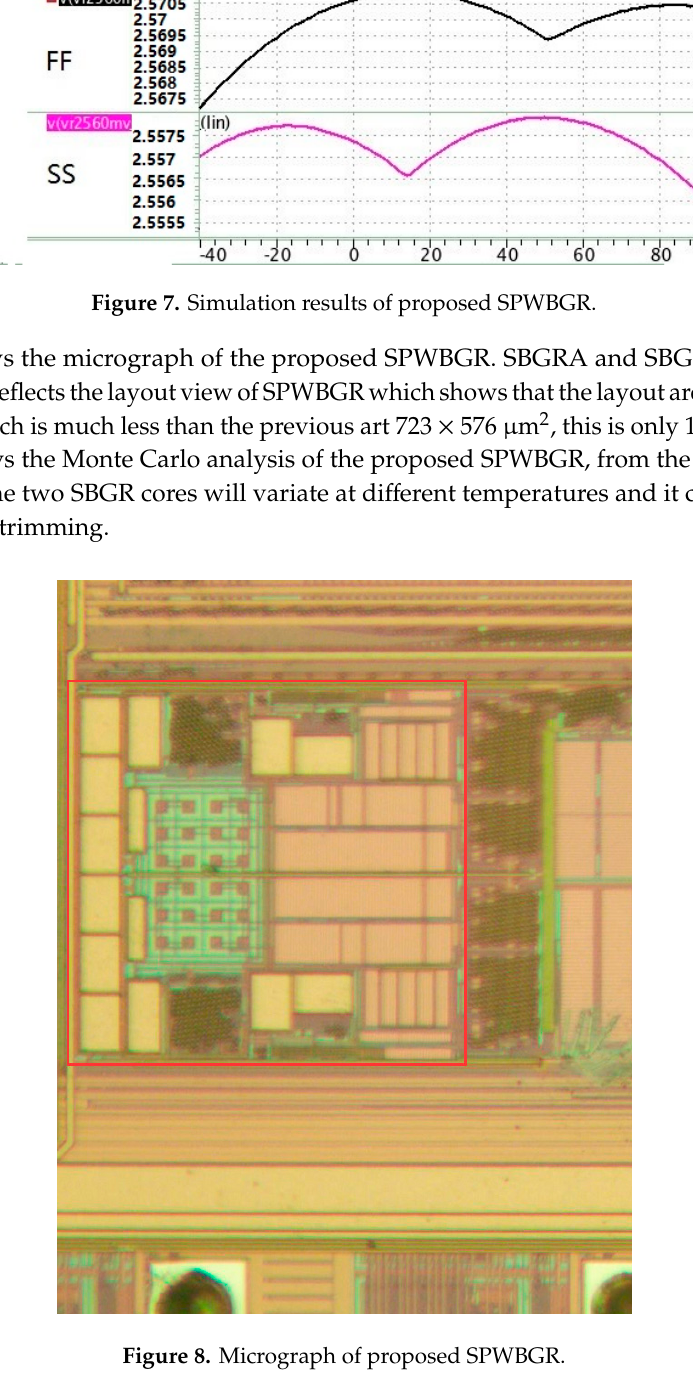
Figure 8. Micrograph of proposed SPWBGR.